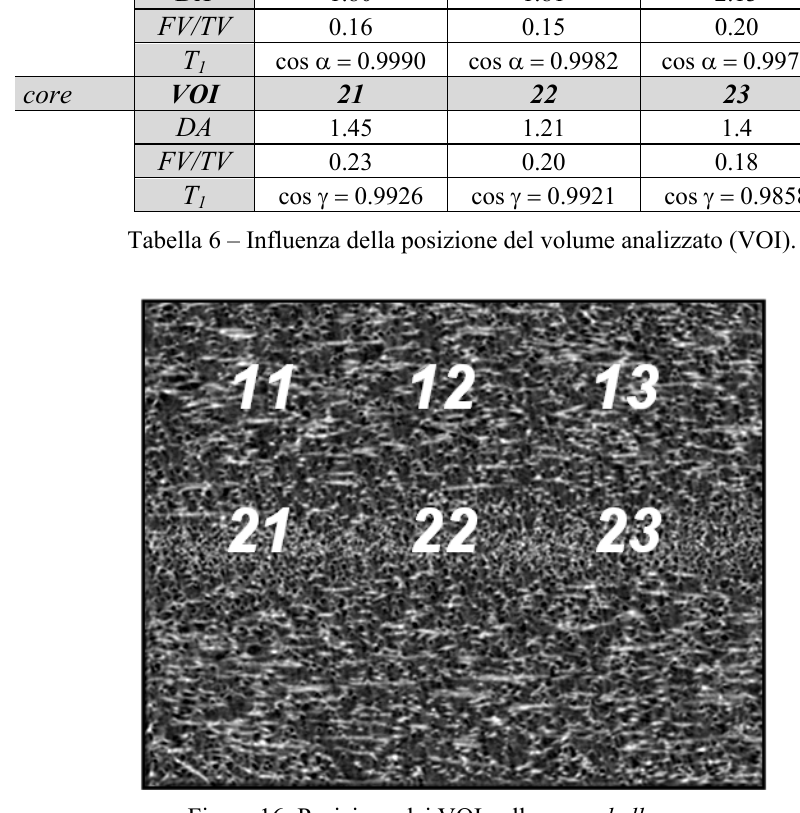
Figura 16: Posizione dei VOI nelle zone shell e